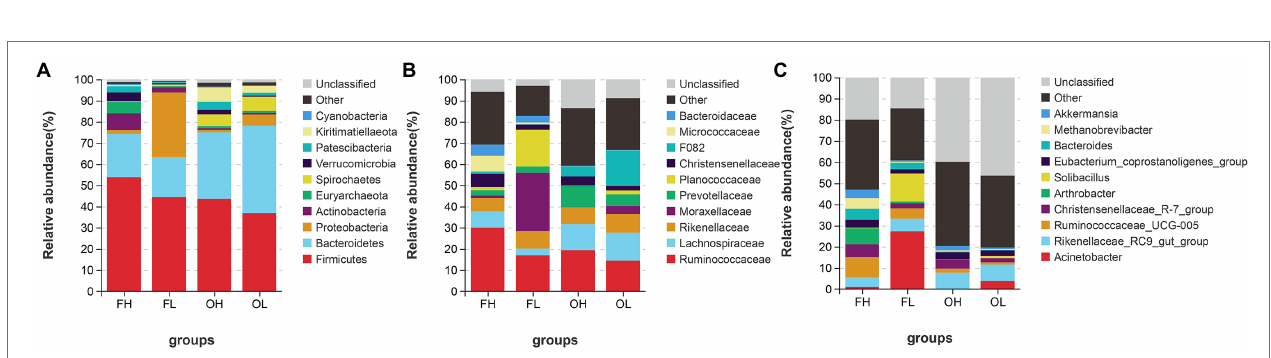
FIGURE 5 | Gut microbiome composition of ungulates at the phylum (A) , family (B) , and genus (C) levels. FH, high-altitude Artiodactyla (including groups HB, HT, and HY); FL, low-altitude Artiodactyla (including groups LB and LY); OH, high-altitude Perissodactyla (group HA); OL, low-altitude Perissodactyla (group